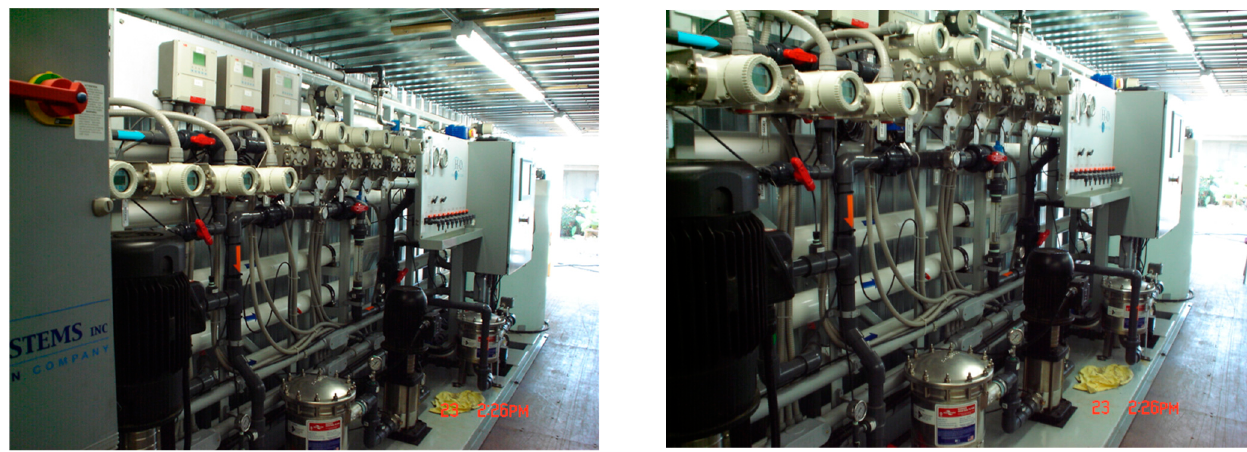
Figure 6. The RO pilot unit for Pilot Study 2.